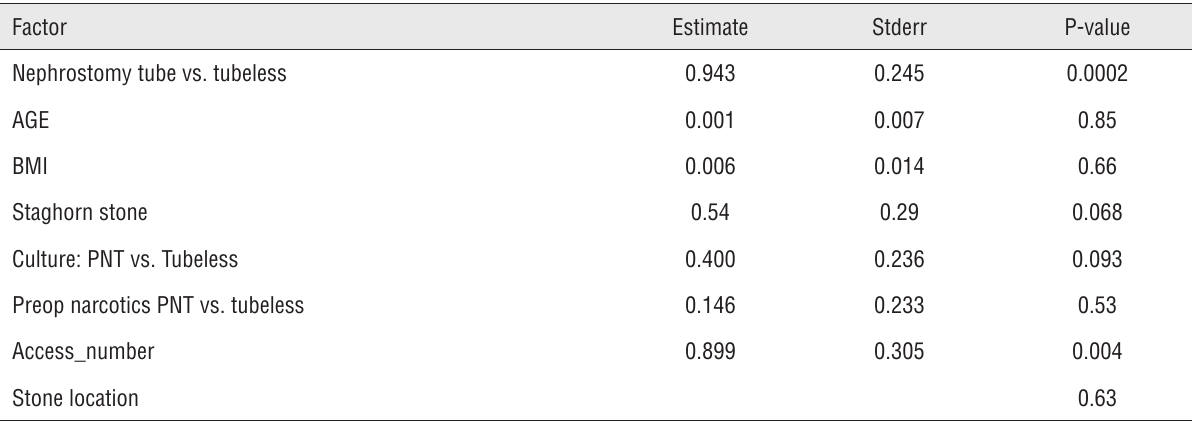
Table 3 - Multi-variable association between hospital stay (LOS) and use of nephrostomy tube, adjusting for other covariates, including age, BMI, culture, pre-op. narcotics, and access number. Factor Estimate Stderr Nephrostomy tube vs. tubeless